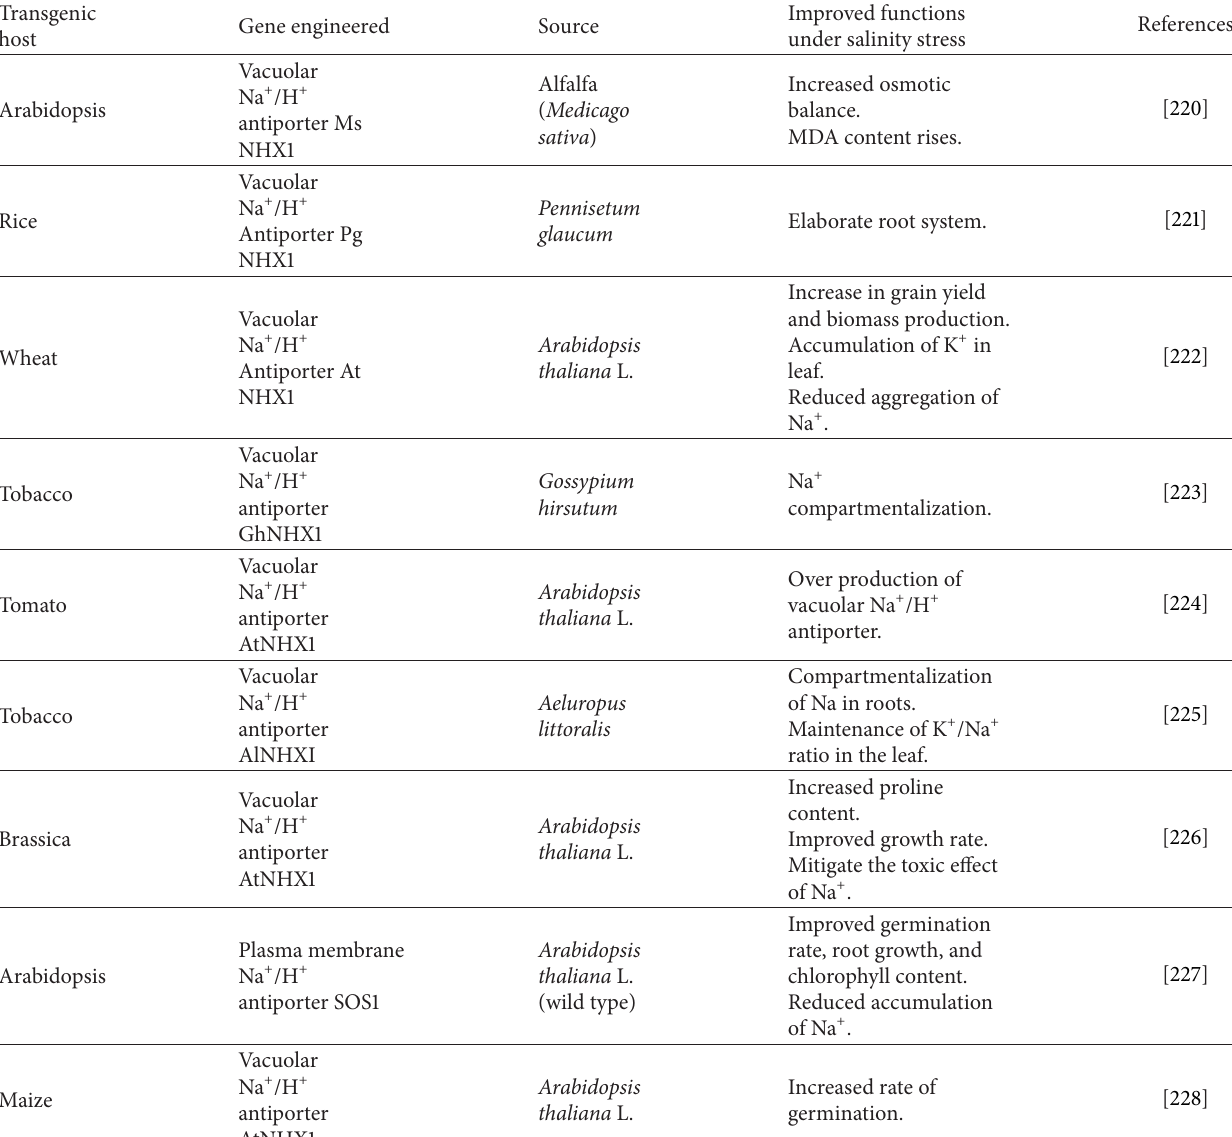
Table 2: Improving plant salt tolerance through engineering genes for various membrane